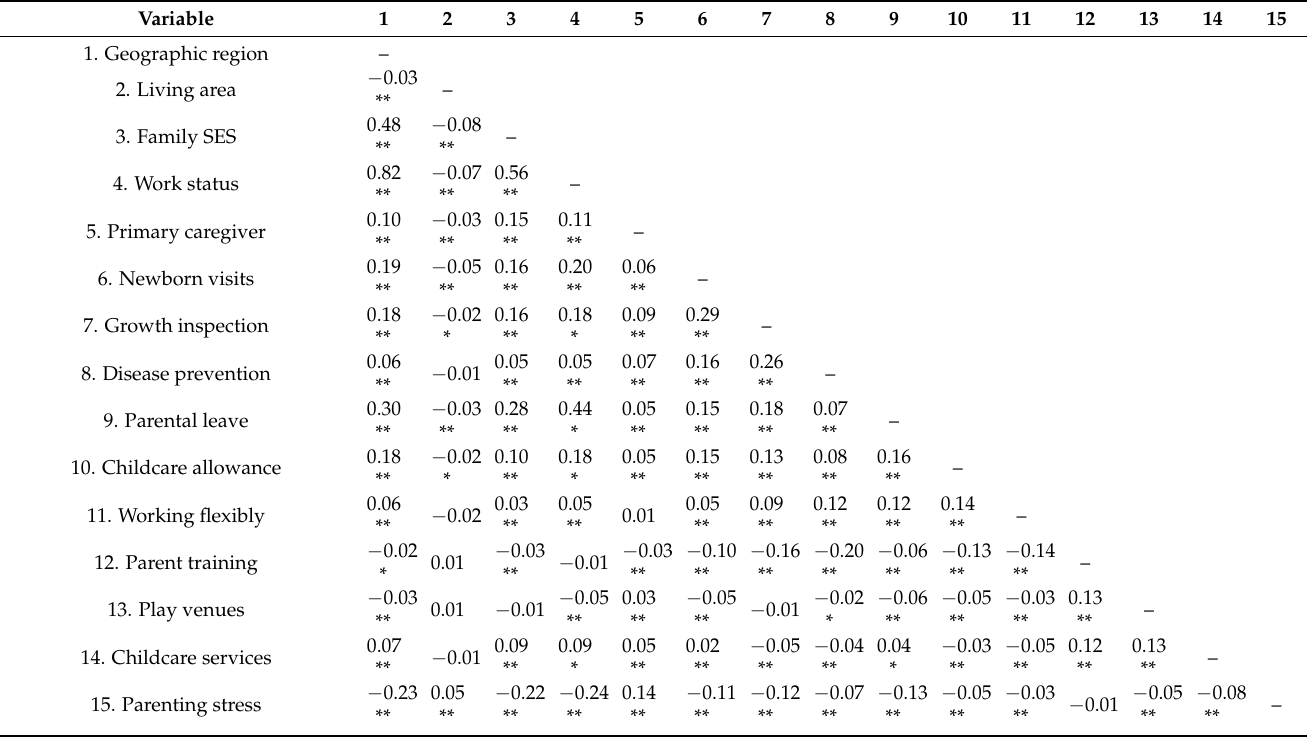
Table 3. Correlations and descriptive statistics for the main study